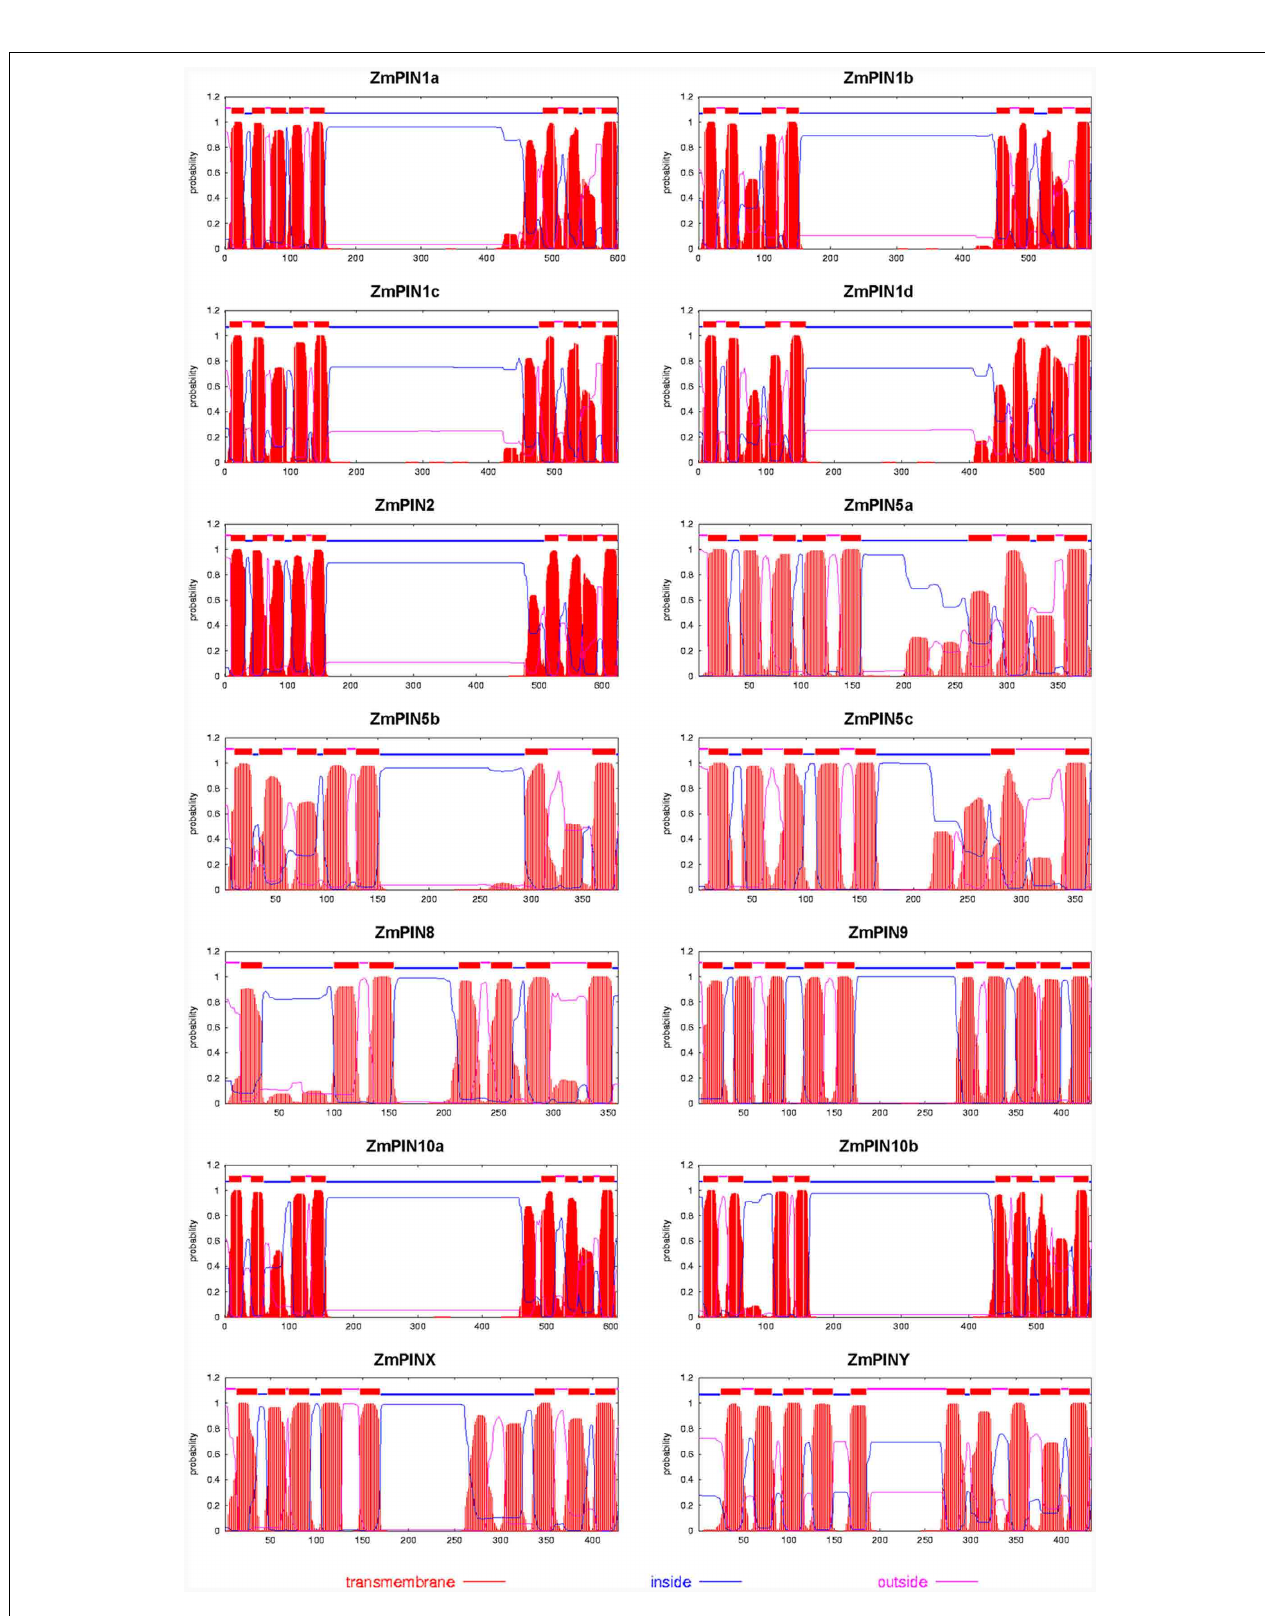
FIGURE 3 |The predicted protein profiles of the maize PIN transporters. The transmembrane helices of PIN proteins were predicted usingTMHMM2